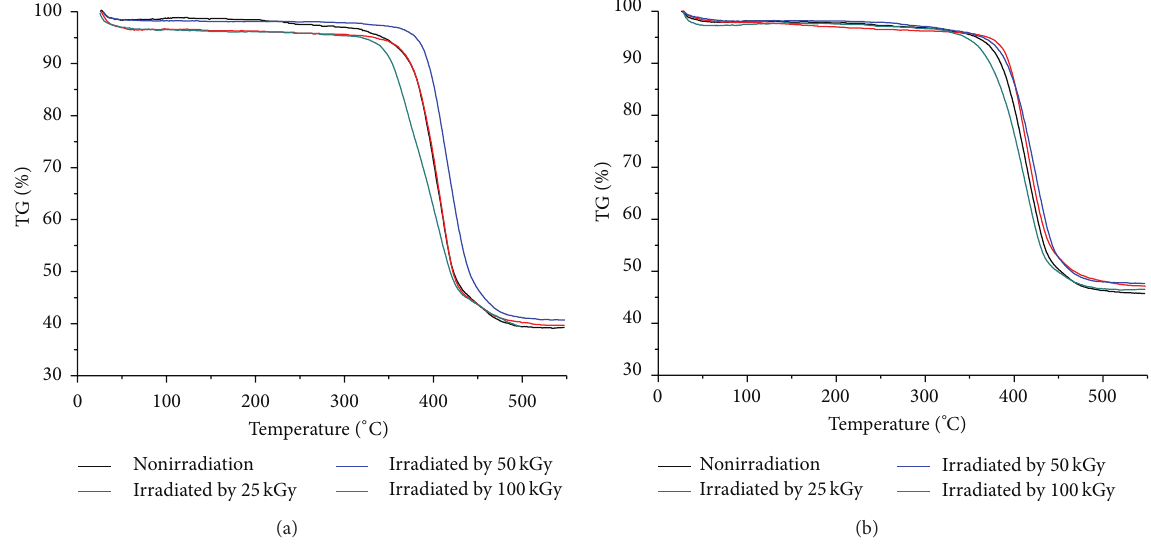
Figure 2: The effect of irradiation dose on TG curves for 40wt% (a) and 50 wt% (b) nHA/PA66 composite scaffolds.